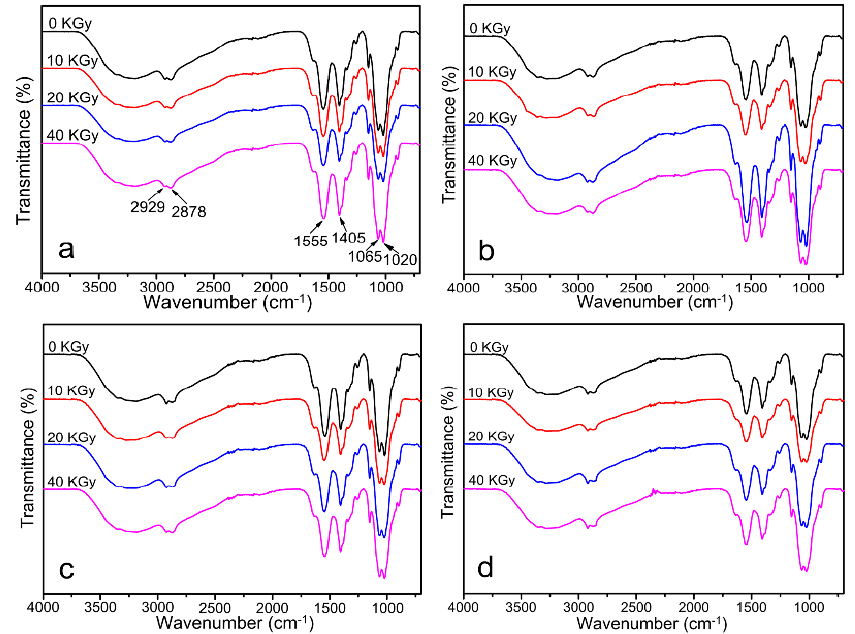
Figure 3. Fourier Transform Infrared (FT - IR) spectra of CS/GO composite films with different content of GO: ( a ) 0 wt %; ( b ) 1 wt %; ( c ) 3 wt %; ( d ) 5 wt % under the various irradiation doses.